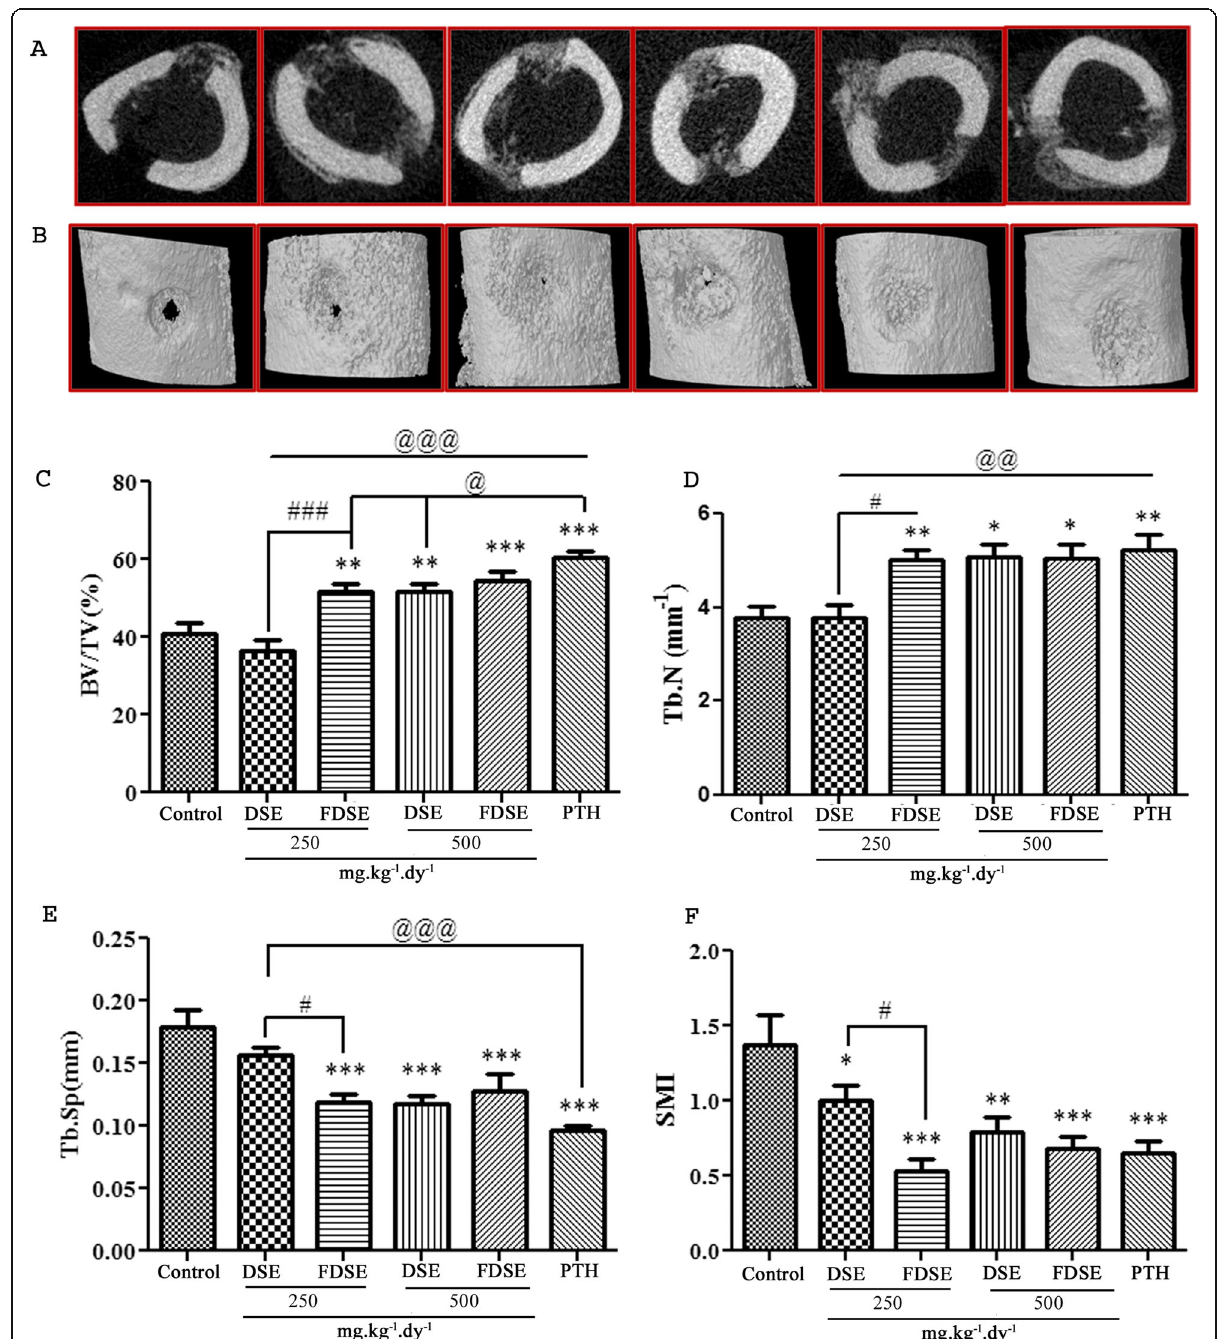
Fig. 2 DSE and FDSE improved micro-architectural parameters in the drill-hole site and accelerates bone regeneration at the fracture site. Representative 2D ( a ) and 3D ( b ) images generated by micro-CT showing bone healing at different doses. Micro-CT analysis showing ( c ) bone volume/tissue volume BV/TV; ( d ) trabecular number (Tb.N); ( e ) trabecular separation (Tb.Sp); ( f ) structure model index (SMI). All values are expressed as Mean ± SEM ( n = 10 rats/group). * p < 0.05, ** p < 0.01, *** p < 0.001 compared with control. # p < 0.05, ## p < 0.01, ### p < 0.001 compared to formulated extract (FDSE) with corresponding dose of extract (DSE). @ p < 0.05, @@ p < 0.01, @@@ p < 0.001 compared to